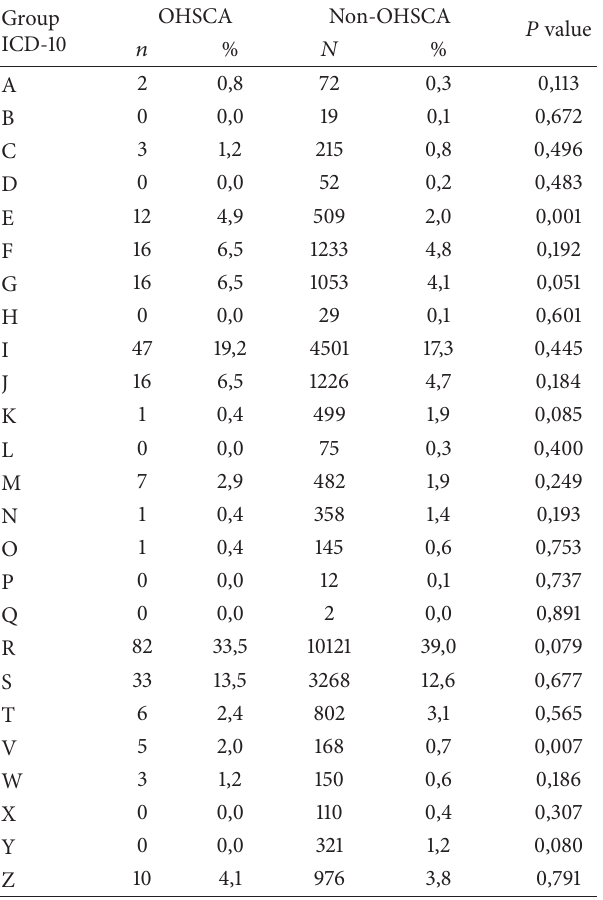
Table 1: Distribution of the incidence of comorbid conditions from given major categories of the ICD-10 classification in patients who developed OHSCA and other patients.